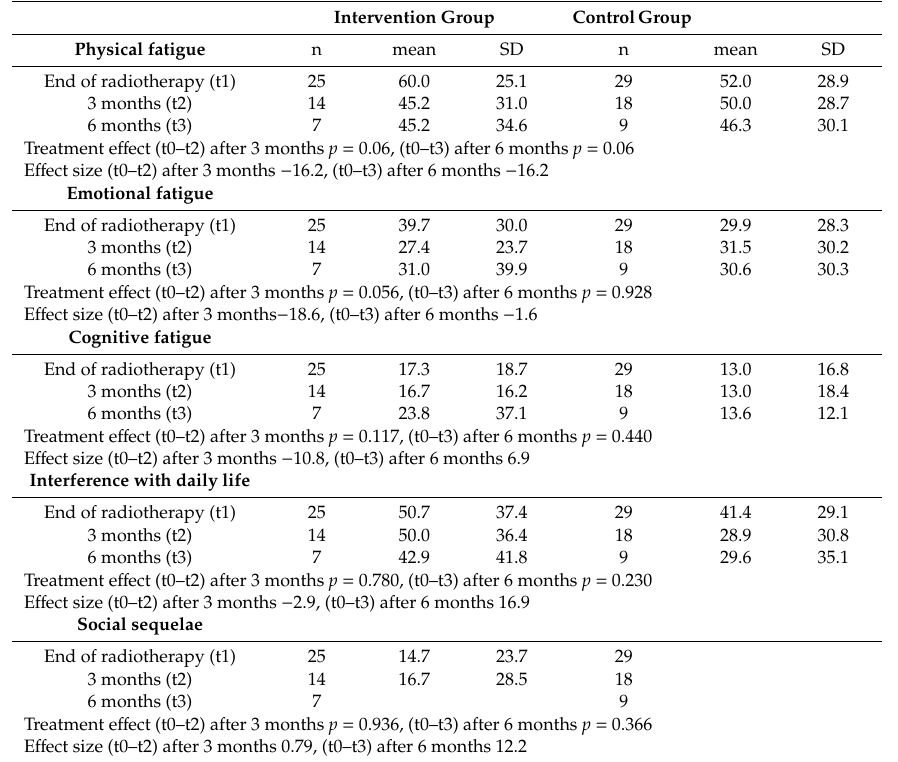
Table 5. E ff ects on fatigue according to EORTC QLQ-FA 13